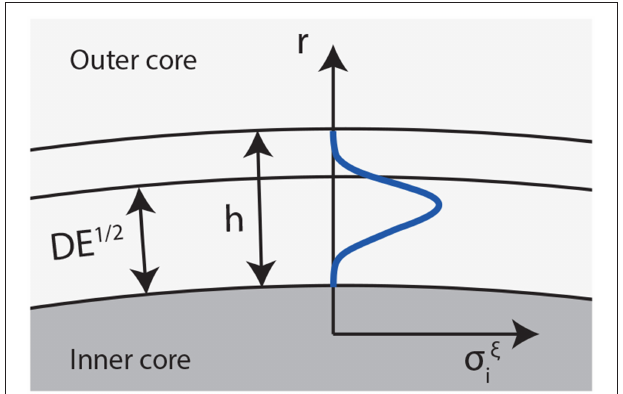
FIGURE 1 | Illustration of the shape of the source term σ ξ i applied above the inner core